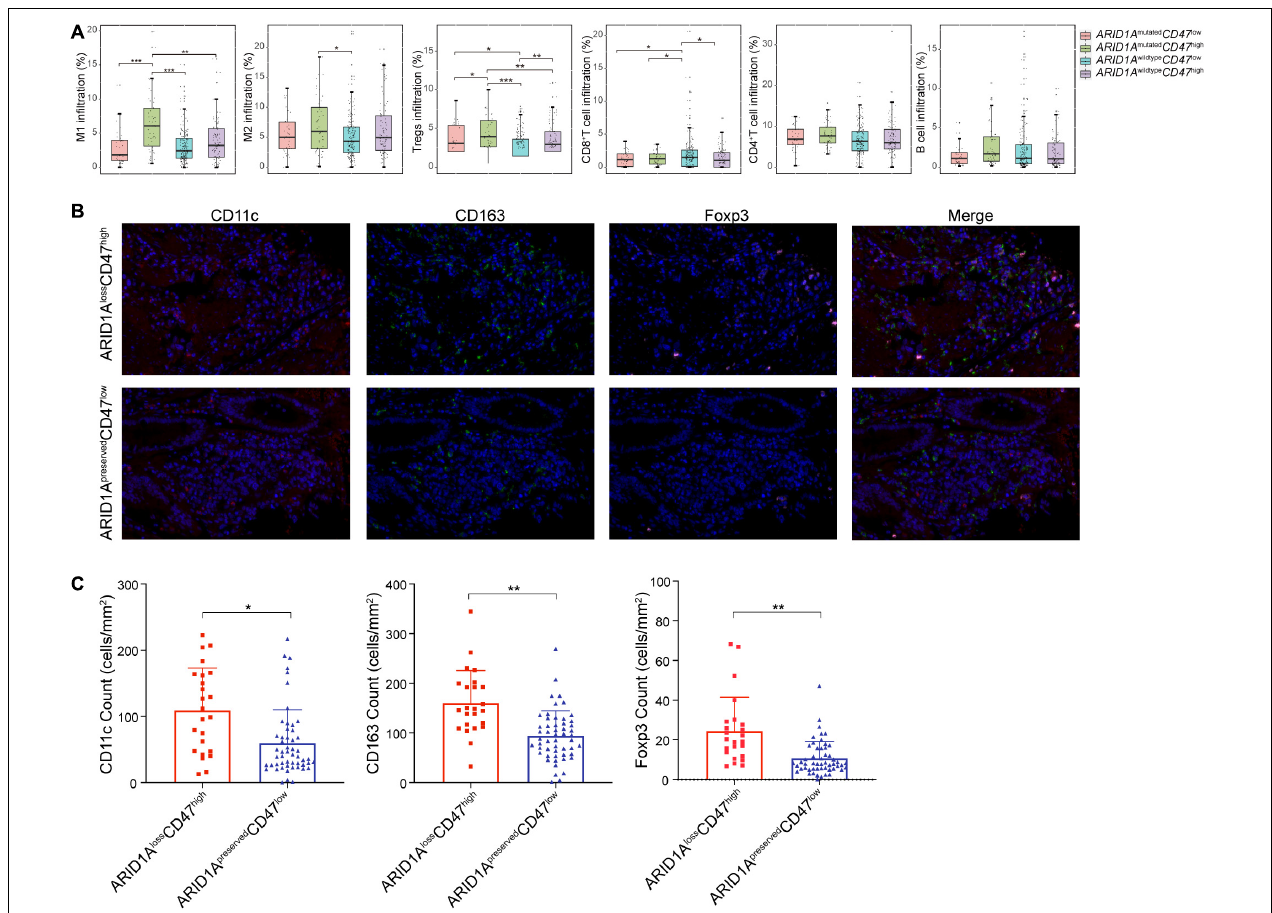
FIGURE 5 | Characterization of tumor-infiltrating immune cells based on ARID1A and CD47 expression. (A) Estimation of tumor-infiltrating immune cells in different subgroups stratified by ARID1A status and CD47 expression. (B) Multiplex immunofluorescent images illustrate GC tissues with ARID1A loss CD47 high or ARID1A preserved CD47 low expression that express CD11c, CD163, and Foxp3. (C) Quantitative analysis of the densities of immune markers between ARID1A loss CD47 high and ARID1A preserved CD47 low GC tissues. Error bars represent mean with SD. * p < 0.05, ** p < 0.01, *** p <